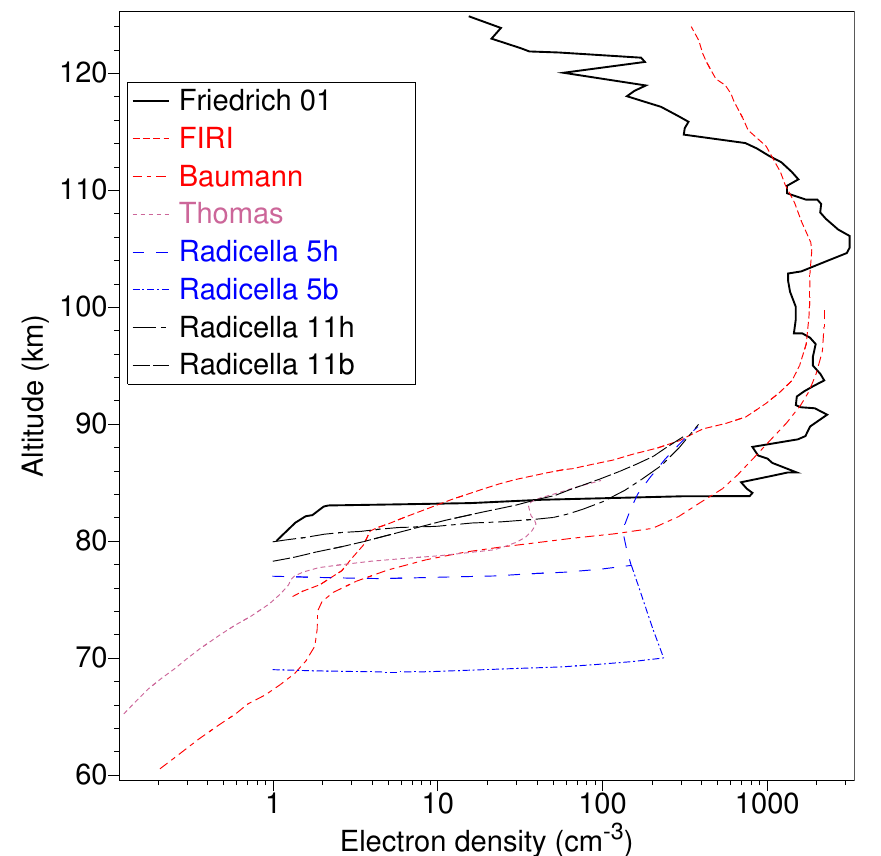
Figure 2. Measured [4] (thick line) and calculated nighttime electron densities as a function of altitude by Friedrich and Torkar [4] (”FIRI”–––), Baumann et al. [12] (—-—), Thomas and Bowman [13] (---) and Radicella [11] (as